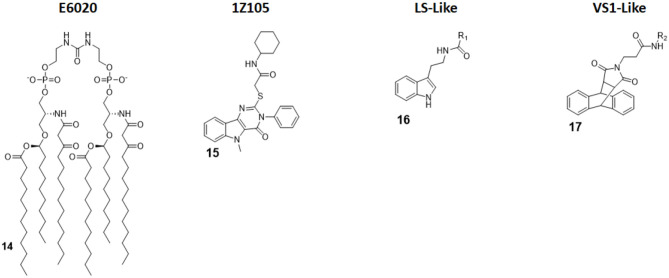
Non-Glycolipid TLR4 agonists. E6020 is a linear lipid A analog developed by Eisai Inc., currently in clinical trial in cancer immunotherapy. 1Z105, a pyrimidoindole, is currently being tested in vivo as vaccine adjuvant. LS- and VS1-like compounds are novel TLR4 agonist structures obtained by computational approach.